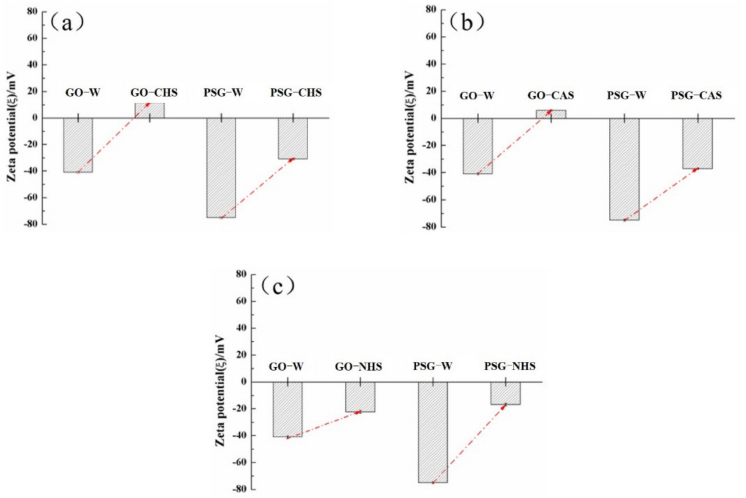
Figure 13. Average zeta potentials of GO and PSG particles in different solution systems: ( a ) CHS; ( b ) CAS; and ( c )